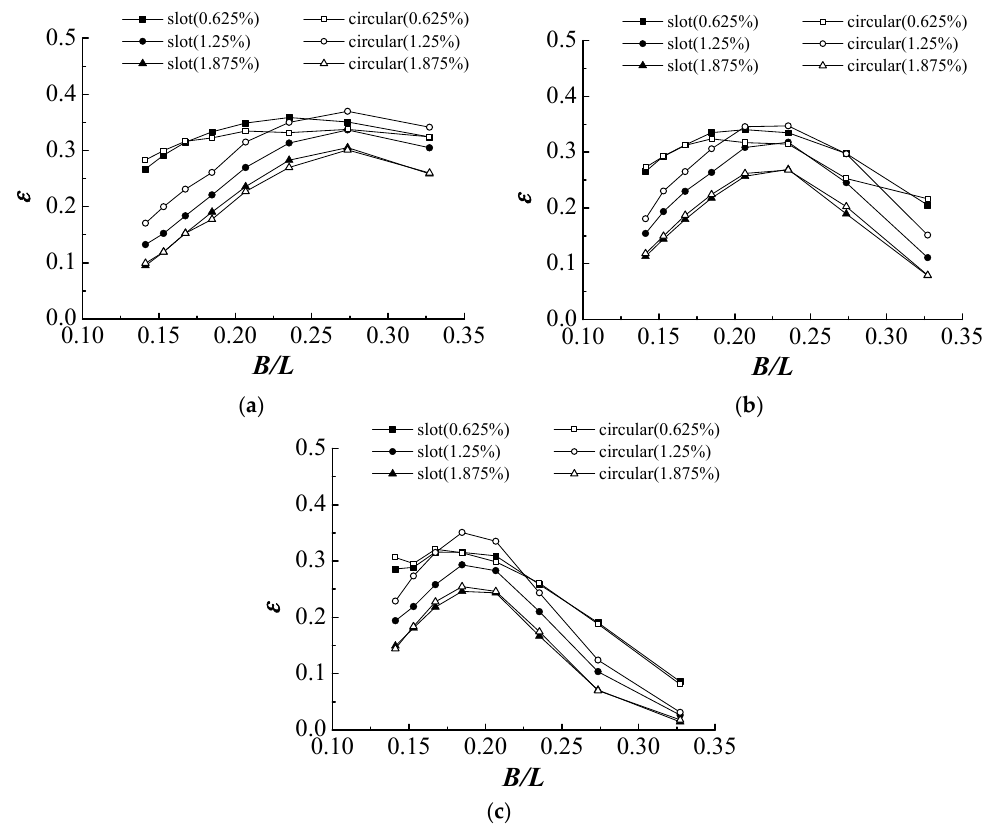
Figure 4. Variations of energy efficiency ε versus B / L for the six tested top openings with: ( a ) 10 cm draft; ( b ) 15 cm draft; ( c ) 20 cm draft.